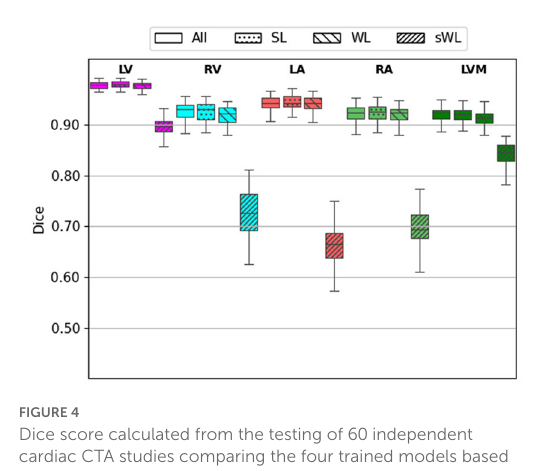
FIGURE4 Dice score calculated from the testing of 60 independent cardiac CTA studies comparing the four trained models based on the All, strong label (SL), weak label (WL), and synthetic weak label (sWL) dataset. Average Dice score is reported for each structure including left and right ventricles (LV, RV), left and right atria (LA, RA), and LV myocardium (LVM).